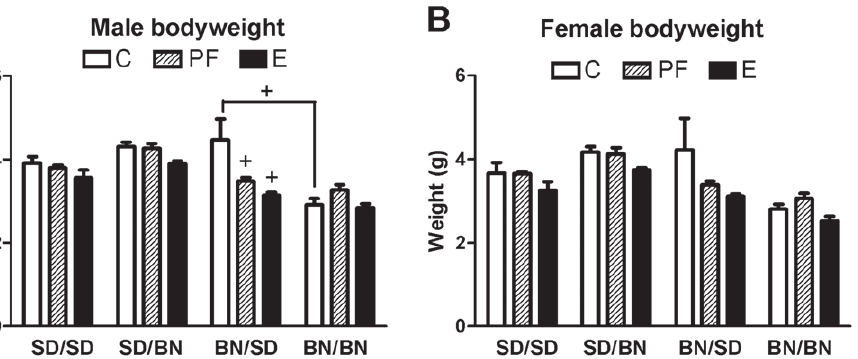
Figure 2. Diet effects on fetal bodyweight are modulated by maternal and paternal genetic backgrounds. Fetal bodyweight of C, PF, and E male and female fetuses (SD/SD, SD/BN, BN/SD, and BN/BN where maternal strain is first) on G21. Means from individual litters were used to calculate group final means 6 SEM as shown. Males (A) and females (B) were separated due to the effect of fetal sex on bodyweight (F [1, 71]=4.5, P =0.04). Fetuses obtained from hybrid crosses weighed more than pure-strain fetuses on G21 (F [1, 71]=53.0, P , 0.001). Alcohol exposure decreased fetal weight (F [2, 71]=15.7, P , 0.001), but BN/BN fetuses were not as vulnerable as BN/SD fetuses (maternal strain x paternal strain x diet: F [2, 71]=5.6, P , 0.01). Data were analyzed by four-way ANOVA with sex as a factor. Planned comparisons were made with Bonferroni adjustment ( + P , 0.0001). Comparisons are relative to the control group of the same fetal strain unless otherwise indicated.